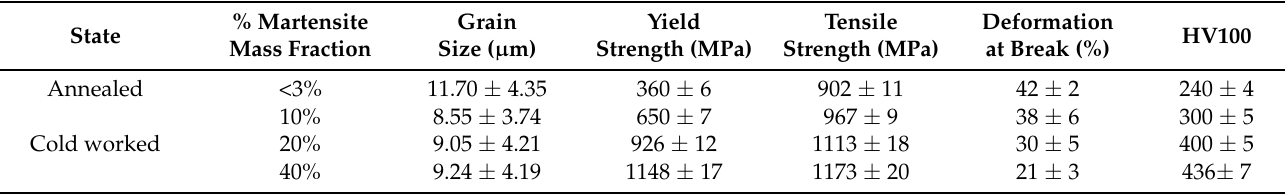
Table 1. Metallographical conditions of the AISI 301LN sheets included in the experimental procedure. After Fargas et al. (2015) [32]. % Martensite Grain Yield State Annealed <3% Cold